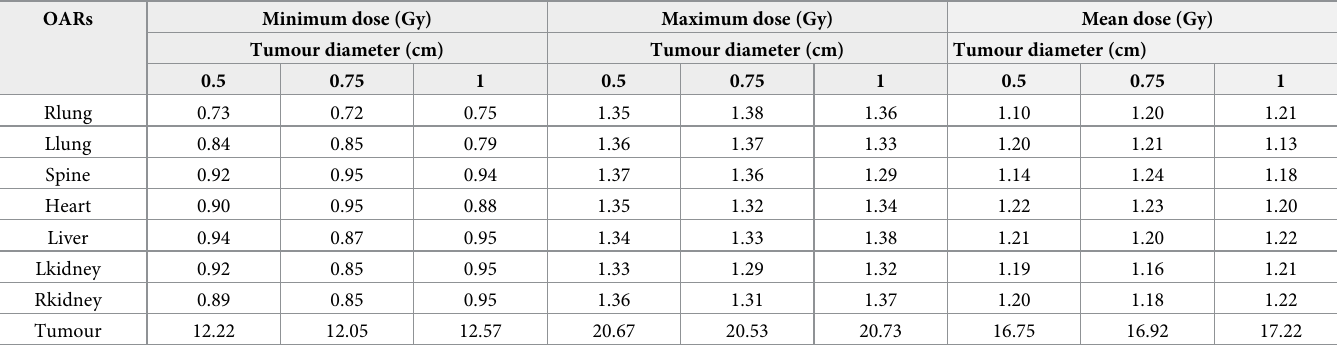
Table 2. Minimum, maximum, and mean doses for the tumour and OARs.